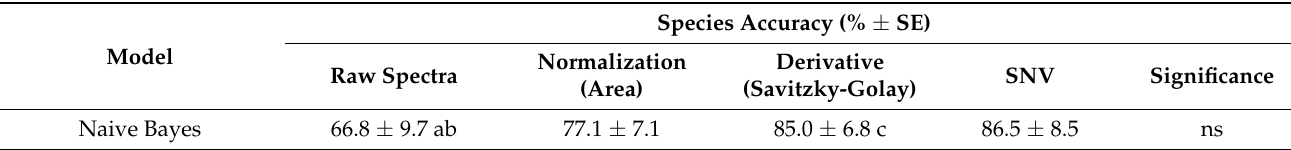
Table 3. Means of percentage of correctly classified six Amaranthus sp. from four different preprocessing and four different classification model using reflectance spectra.